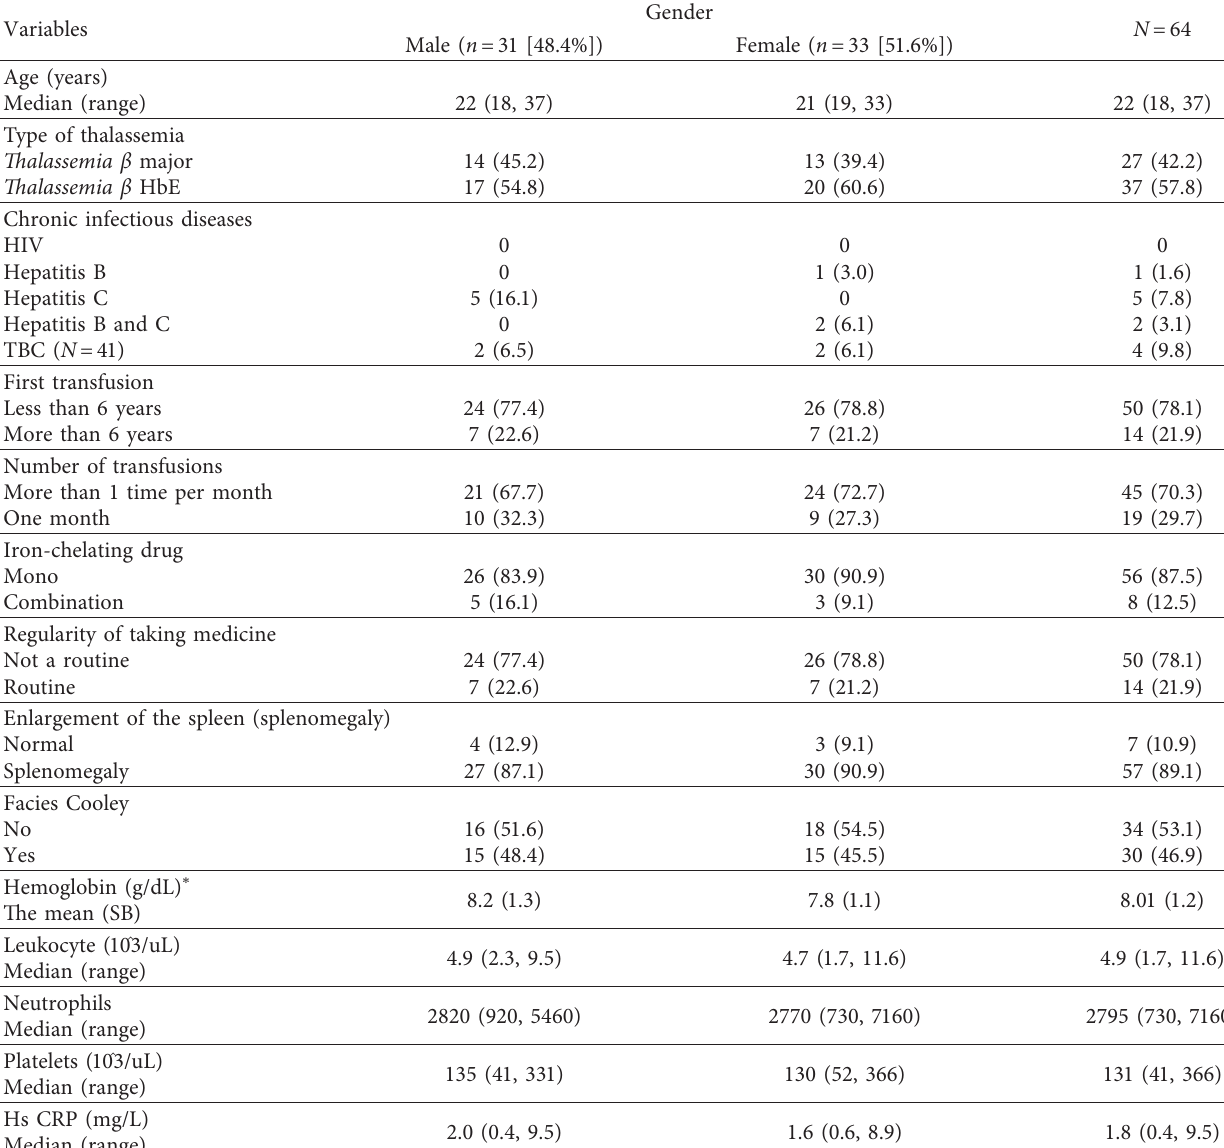
Table 1: Baseline characteristics of study subjects.